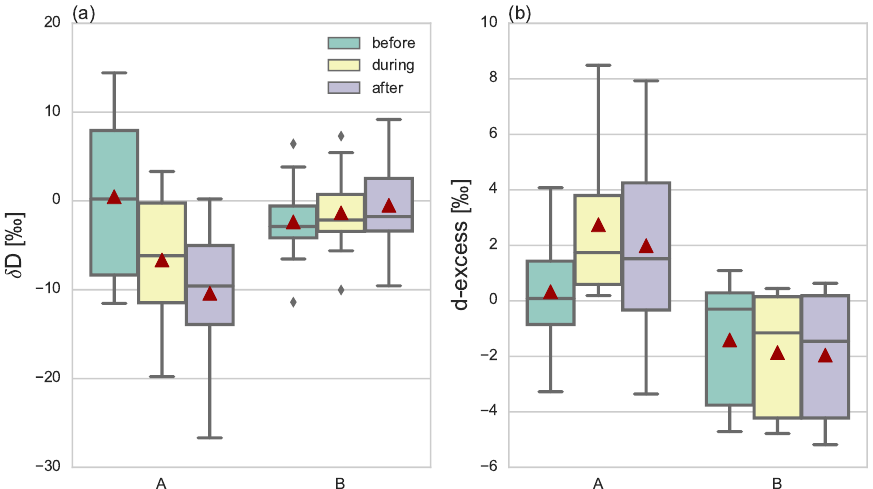
Figure 8. Anomalies relative to the respective daily mean for ( a ) δ D and ( b ) d-excess before (green), during (yellow), and after (purple) observed type A and type B rainfall